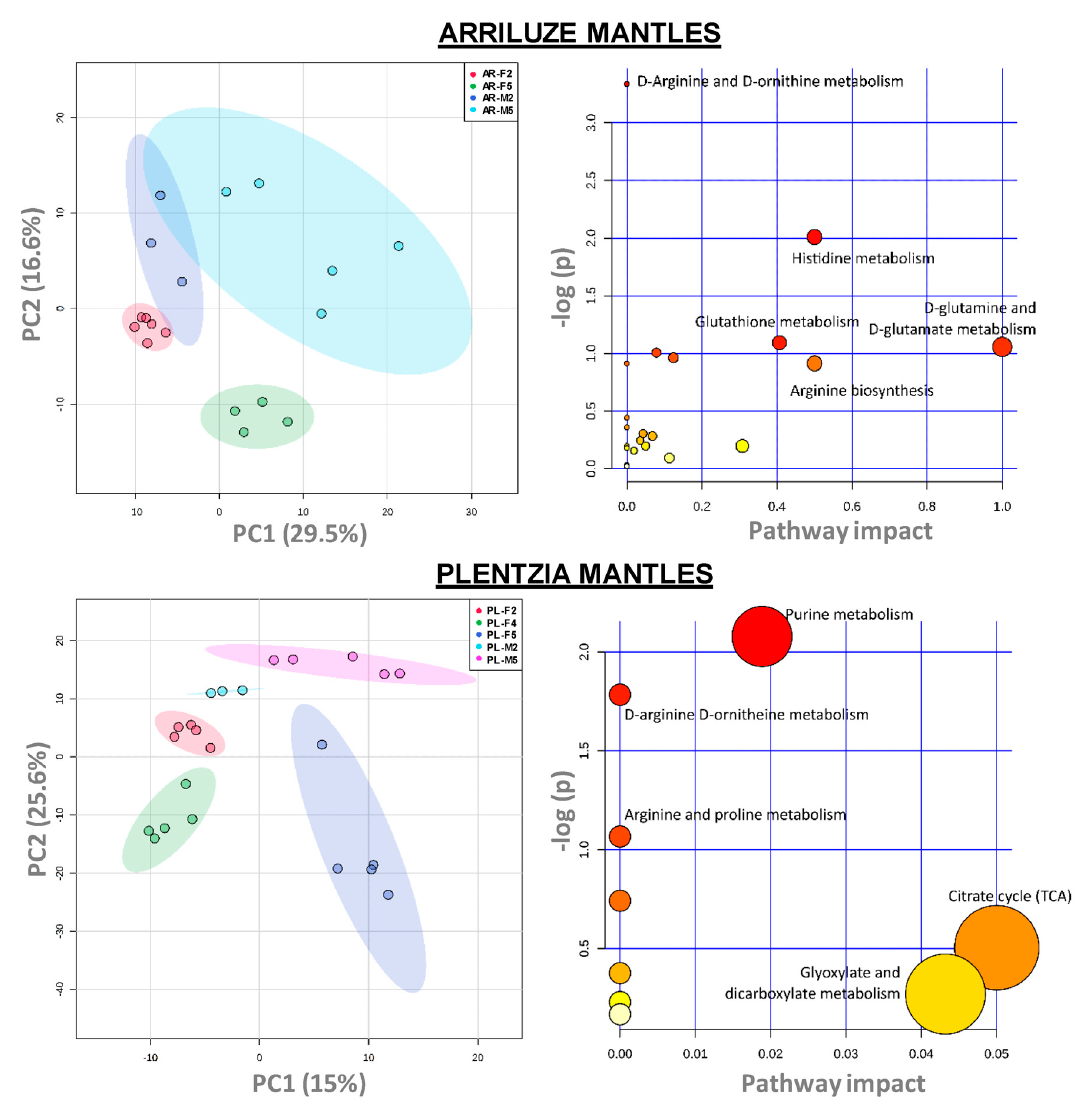
Figure 5. Metabolic pathway analysis comparing male and female mantle from Arriluze. Score projection (PC1-PC2) of the partial least squares-discriminant analysis (PLS-DA) analysis of the metabolites of male and female mantles in Arriluze and Plentzia show clustering of samples according to sex and gametogenic stage. Pathway analysis plot (impact pathway) of the most significant metabolites identified in the previous analysis in Arriluze and Plentzia is also shown. The color and size of each circle are based on p -value and pathway impact value, respectively. The most impacted pathways having high statistical significance scores are indicated. Caenorhabditis elegans pathway library was used for the analysis. Supplementary Tables S2 and S3 show Mbrole 2.0 results indicating levels of significance and amounts of